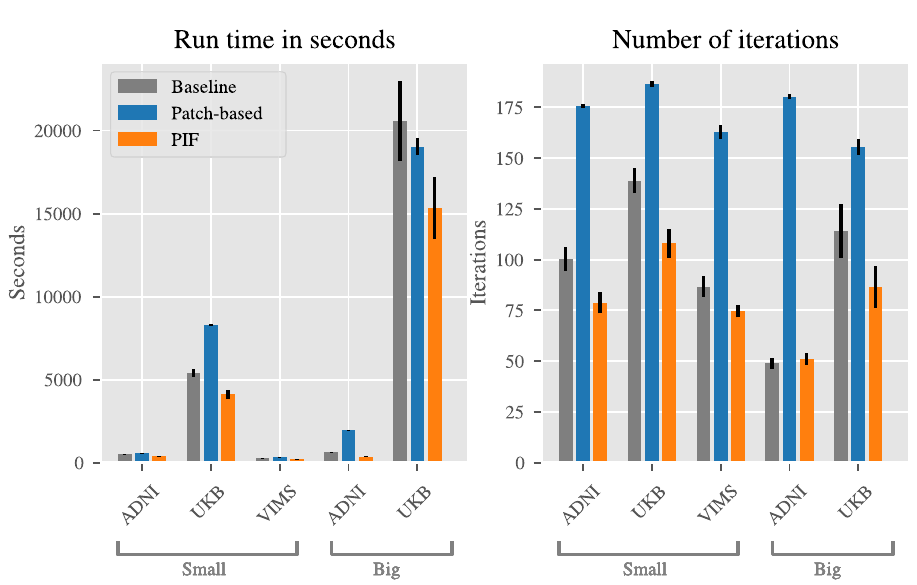
Figure 6. Training time for all runs in seconds and number of iterations. Error bars depict standard